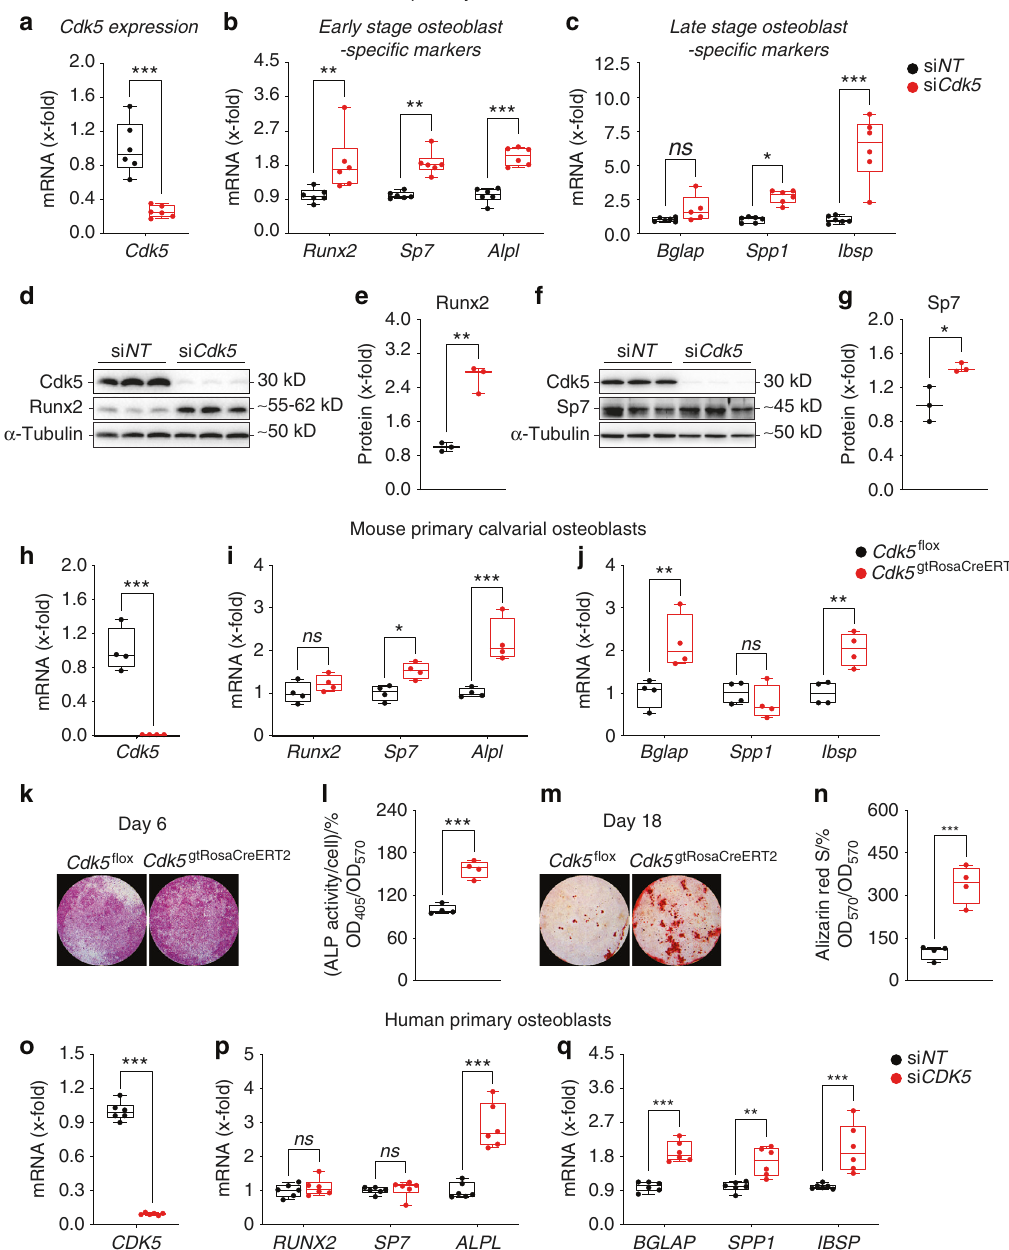
Fig. 2 Cdk5 silencing or genetic deletion increases osteoblast-speci fi c marker gene expression in primary murine and human osteoblasts. a Cdk5 mRNA expression in primary murine calvarial osteoblasts after 8 days of siRNA transfection was quanti fi ed by qPCR ( n = 6). b and c qPCR analysis of early-stage ( Runx2, Sp7, Alpl ) and late-stage ( Bglap, Ibsp, Spp1 ) osteoblast-speci fi c marker gene expression in the primary murine calvarial osteoblasts transfected with non-targeting siRNA (si NT ) control or Cdk5 -speci fi c siRNA (si Cdk5 ) at 8 and 16 days post- transfection, respectively ( n = 6). d and e Runx2 protein levels by western blotting and quanti fi cation, respectively, in the primary murine calvarial osteoblasts transfected with si NT or si Cdk5 at 8 days post-transfection ( n = 3). f and g Sp7 protein levels by western blotting and quanti fi cation, respectively, in the primary murine calvarial osteoblasts transfected with si NT or si Cdk5 at 8 days post-transfection ( n = 3). h Cdk5 mRNA expression in the primary murine calvarial osteoblasts isolated from Cdk5 fl ox and Cdk5 gtRosaCreERT2 pups after 8 days of seeding, quanti fi ed by qPCR ( n = 4). i and j qPCR analysis of early-stage ( Runx2, Sp7, Alpl ) and late-stage ( Bglap, Ibsp, Spp1 ) osteoblast-speci fi c marker gene expression from the Cdk5 fl ox and Cdk5 gtRosaCreERT2 primary murine calvarial osteoblasts after 8 and 16 days of culture, respectively ( n = 4). k and l Qualitative and quantitative ALP staining, respectively, of the primary murine calvarial osteoblasts isolated from Cdk5 fl ox and Cdk5 gtRosaCreERT2 pups after 8 days of culture ( n = 4). m and n Qualitative and quantitative Alizarin Red S staining, respectively, from the primary murine calvarial osteoblasts isolated from Cdk5 fl ox and Cdk5 gtRosaCreERT2 pups after 20 days of culture ( n = 4). o CDK5 mRNA expression in human primary osteoblasts at 12 days post-siRNA transfection quanti fi ed by qPCR ( n = 6). p and q qPCR analysis of early-stage ( RUNX2, SP7, ALPL ) and late-stage ( BGLAP, IBSP, SPP1 ) osteoblast-speci fi c marker gene expression in the human primary osteoblasts transfected with si NT control or si CDK5 at 12 days post-transfection, respectively ( n = 6). Data are represented as box-and-whisker plots with min. to max. as well as with superimposition of all the data points. Statistical differences between two groups were determined by unpaired homoscedastic two- tailed Student ’ s t test and two-way ANOVA with Sidak ’ s multiple comparisons test. * P < 0.05, ** P < 0.01, *** P <